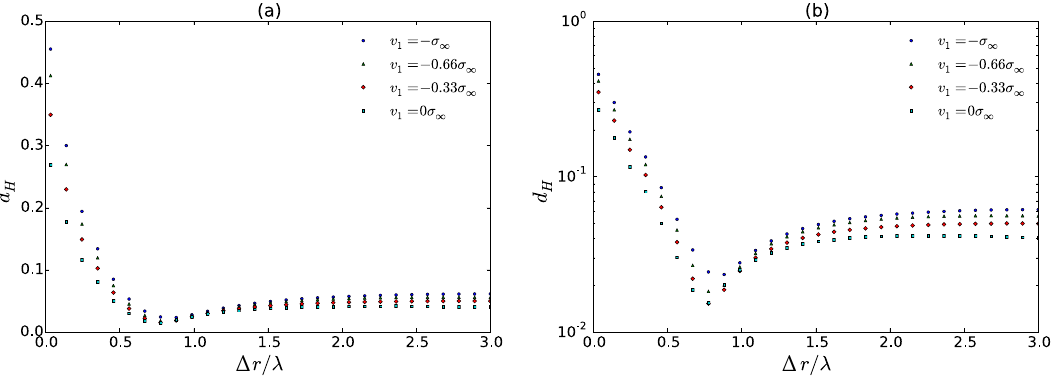
Figure 9. ( a ) Hellinger distance d H ( ∆ r ) for different v 1 and variable step width ∆ r .